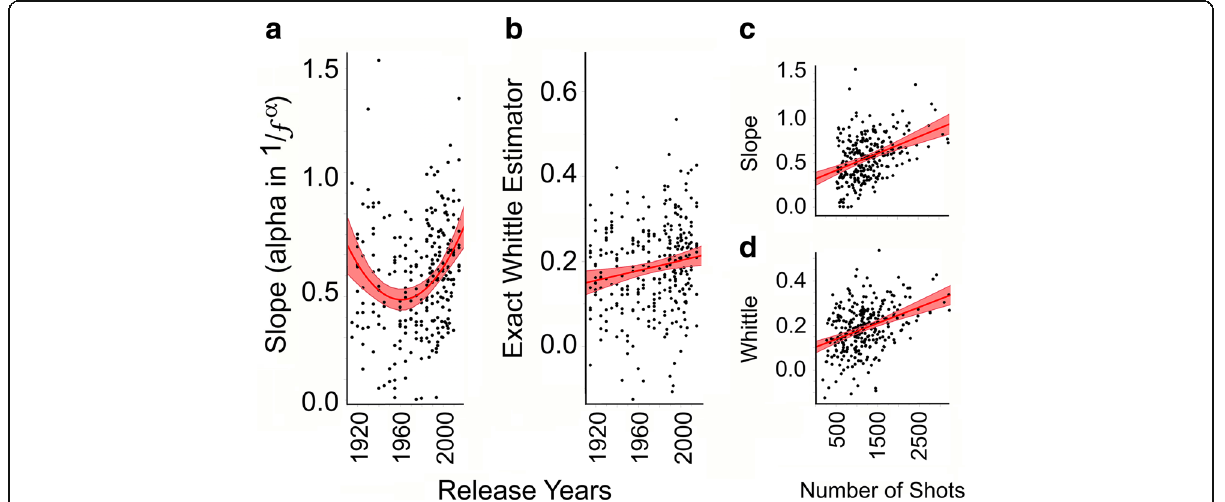
Fig. 4 Results of Studies 1 and 2 plotting values of fractal measurements per movie against release years and against number of shots per movie. Shown are four scatterplot results for movies released between 1915 and 2015. a Alpha values (slopes) of 263 movies as a quadratic function of release year (Study 1). Only the right half of that function fits the data well. b The exact Whittle estimate values for 295 movies as a linear function of release year (Study 2). c The slopes as a function of the number of shots in 263 movies (Study 1). d The Whittle estimates for 295 movies as a function of the number of shots (Study 2). Colored areas are 95% confidence intervals on the regressed